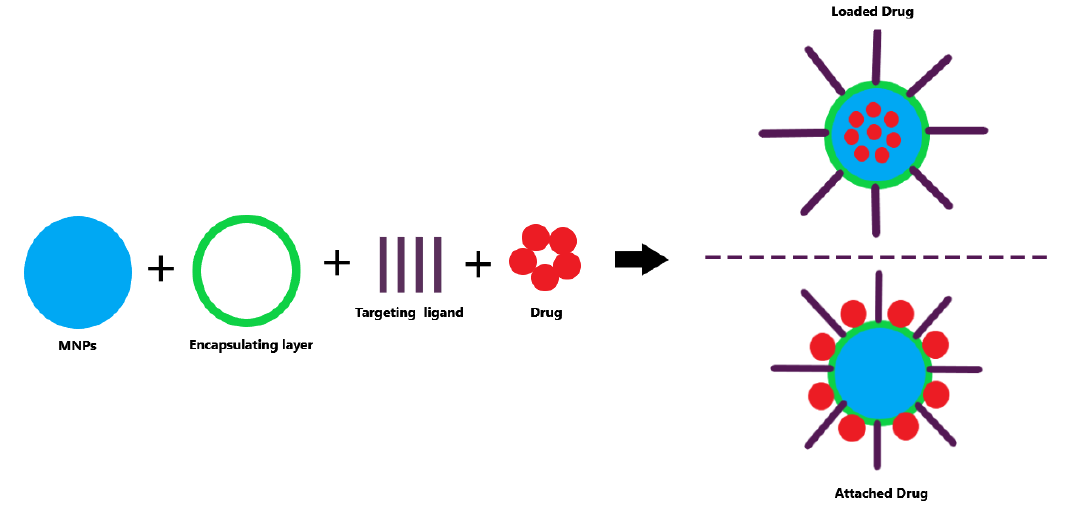
Figure 10. Illustration of drug loading roots in TDD.